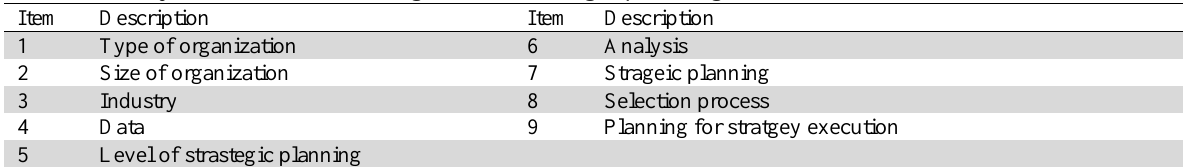
The summary of criteria for ranking different stratgic